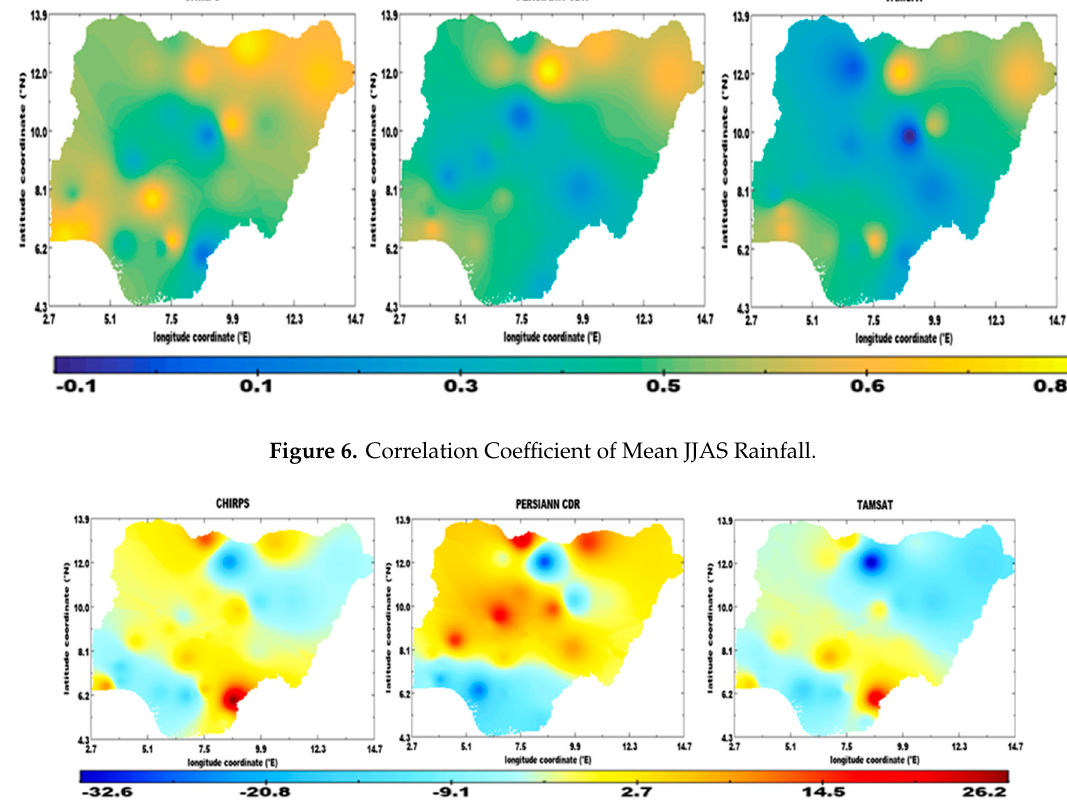
Figure 8. Root mean square error (RMSE) of mean JJAS rainfall. 3.6.2. Inter-Annual Variation of Mean Annual Rainfall The results in this section reveal the inter-annual variation of annual rainfall (mm/year) of all products. Findings from Figure 9 show that CHIRPS was able to reproduce observed annual rainfall with good correlation values (r > 0.4) at Bida, Ikom, Kaduna, and Katsina. A greater portion of the Savannah zone was not well captured by the PERSIANN and TAMSAT data. The northwest region of the Sahel zone was also poorly represented by the TAMSAT product, exhibiting low correlation of less than 0.4. Figure 9. Correlation coefficient of annual rainfall (mm/year) over Nigeria. The spatial plot of satellite products bias from gauge datasets is depicted in Figure 10. Both CHIRPS and TAMSAT show the same pattern of bias with model overestimations of gauge datasets